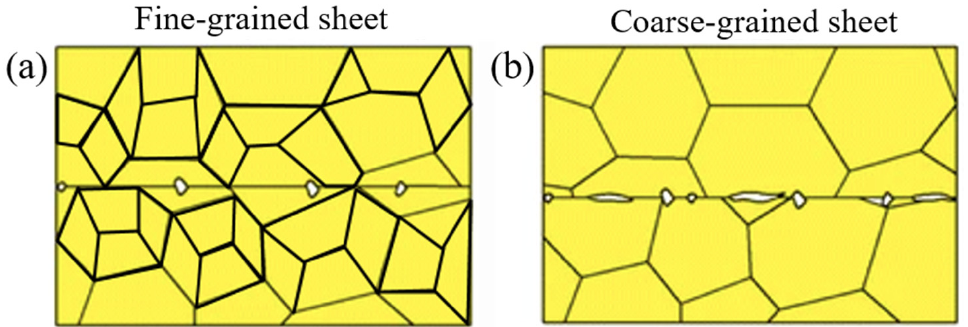
Figure 9. Schematic illustration of the diffusion bonding process for the ( a ) fine-grained and ( b ) ( b ) coarse-grained coarse-grained alloys.